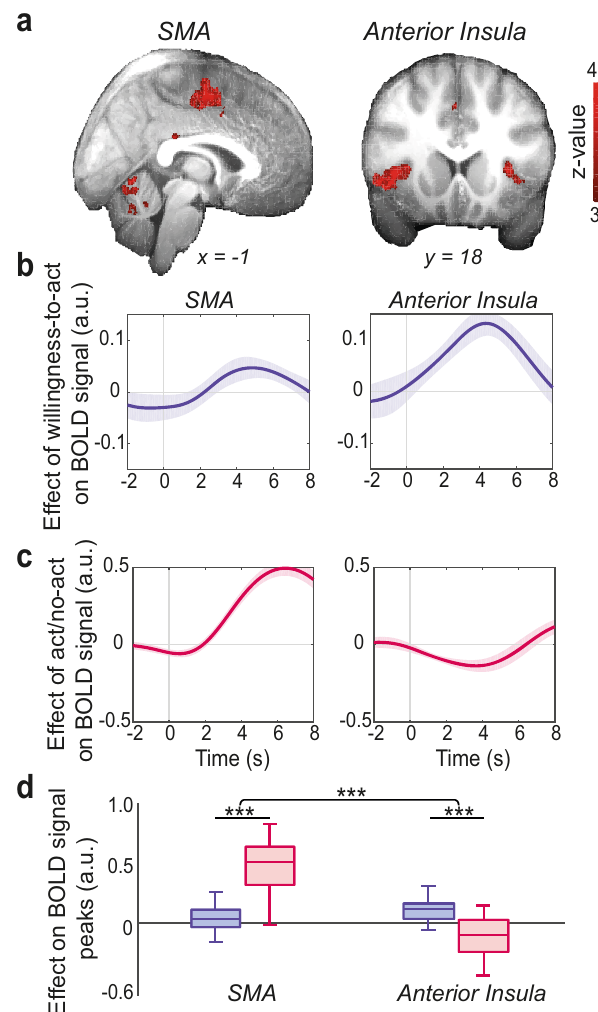
Anterior Insula